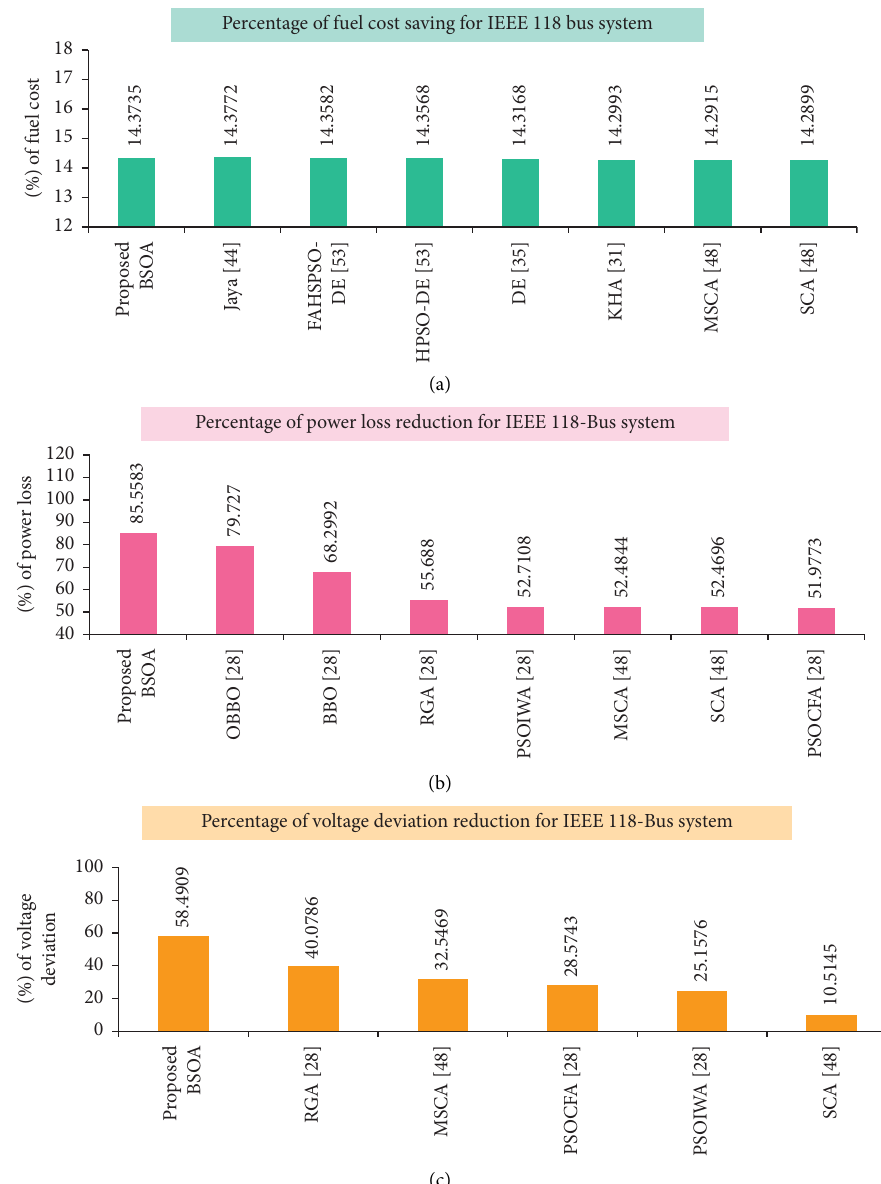
Figure 16: Percentage of fuel cost savings, active power loss reduction, voltage deviation reduction, and voltage stability improvement of the IEEE 118-bus system from base case: (a) fuel cost savings (Case 29); (b) active power loss reduction (Case 30); (c) voltage deviation reduction (Case